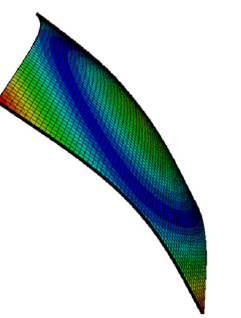
Figure 12. Second-mode shapes of a 150 × 150 × 1.5 mm 3 plate from Abaqus software. (Red arrow = FC).